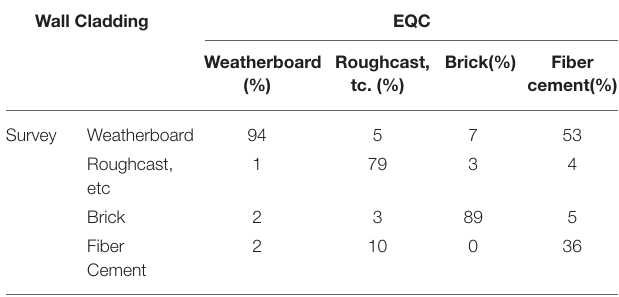
TABLE 8 | Distribution of roof cladding types in various age bands. Age_band Roof_cladding Sample